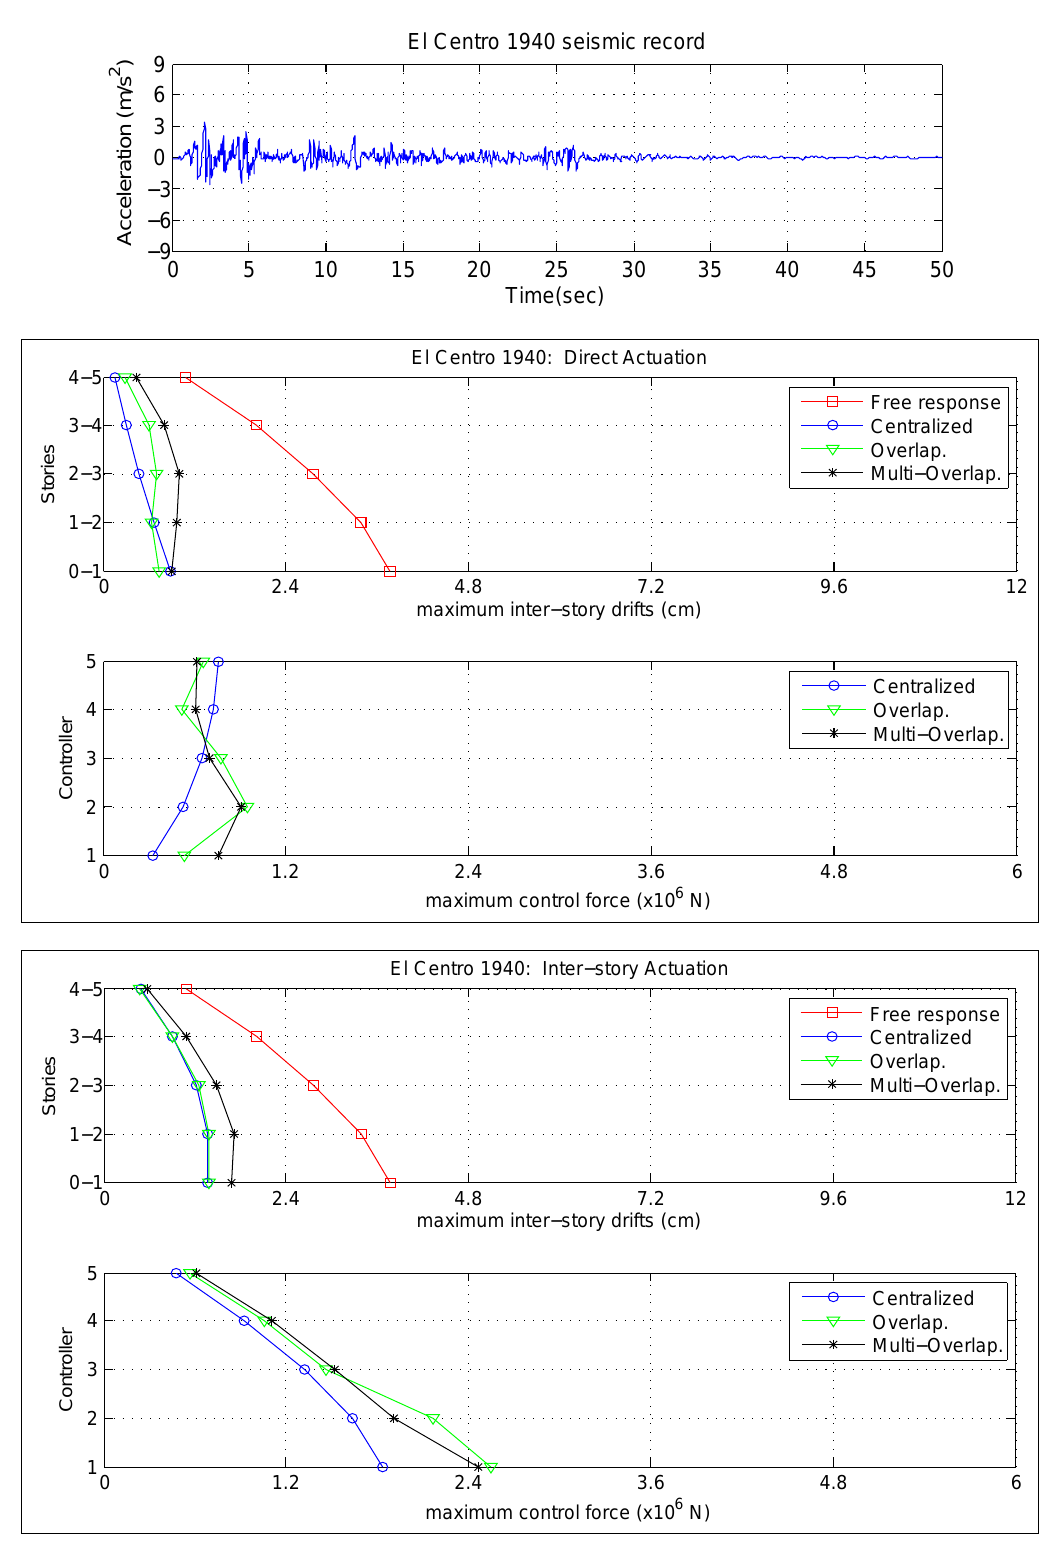
Figure 11: El Centro 1940 seismic record. Maximum inter-story drifts and control